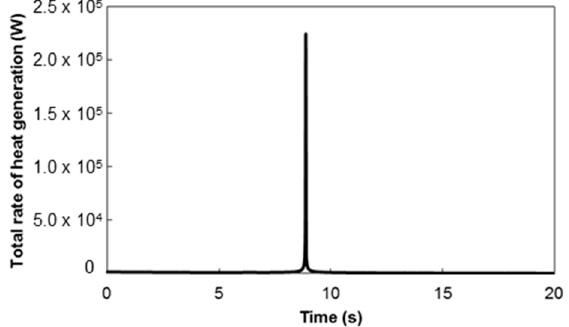
Figure 6. Total rate of heat generation in the battery during short-circuit. Table 5. Total heat release and heat release rate during short-circuit.